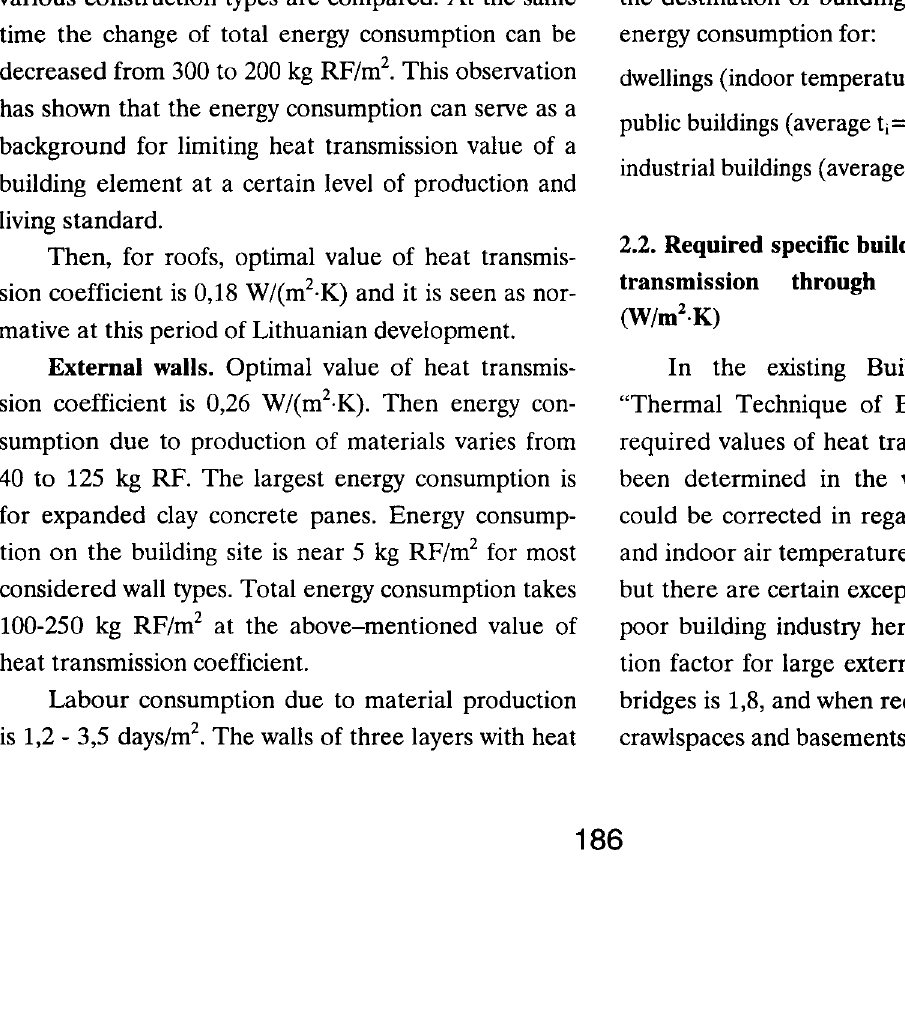
Fig 1. The dependence of energy consumption C, [Energy consumption for heating E during 10 years of service, energy consumption for production of materials M and total energy consump tion B (M +E) ], due to the total thermal resistance Rt> kg of RF/m 2 of a building